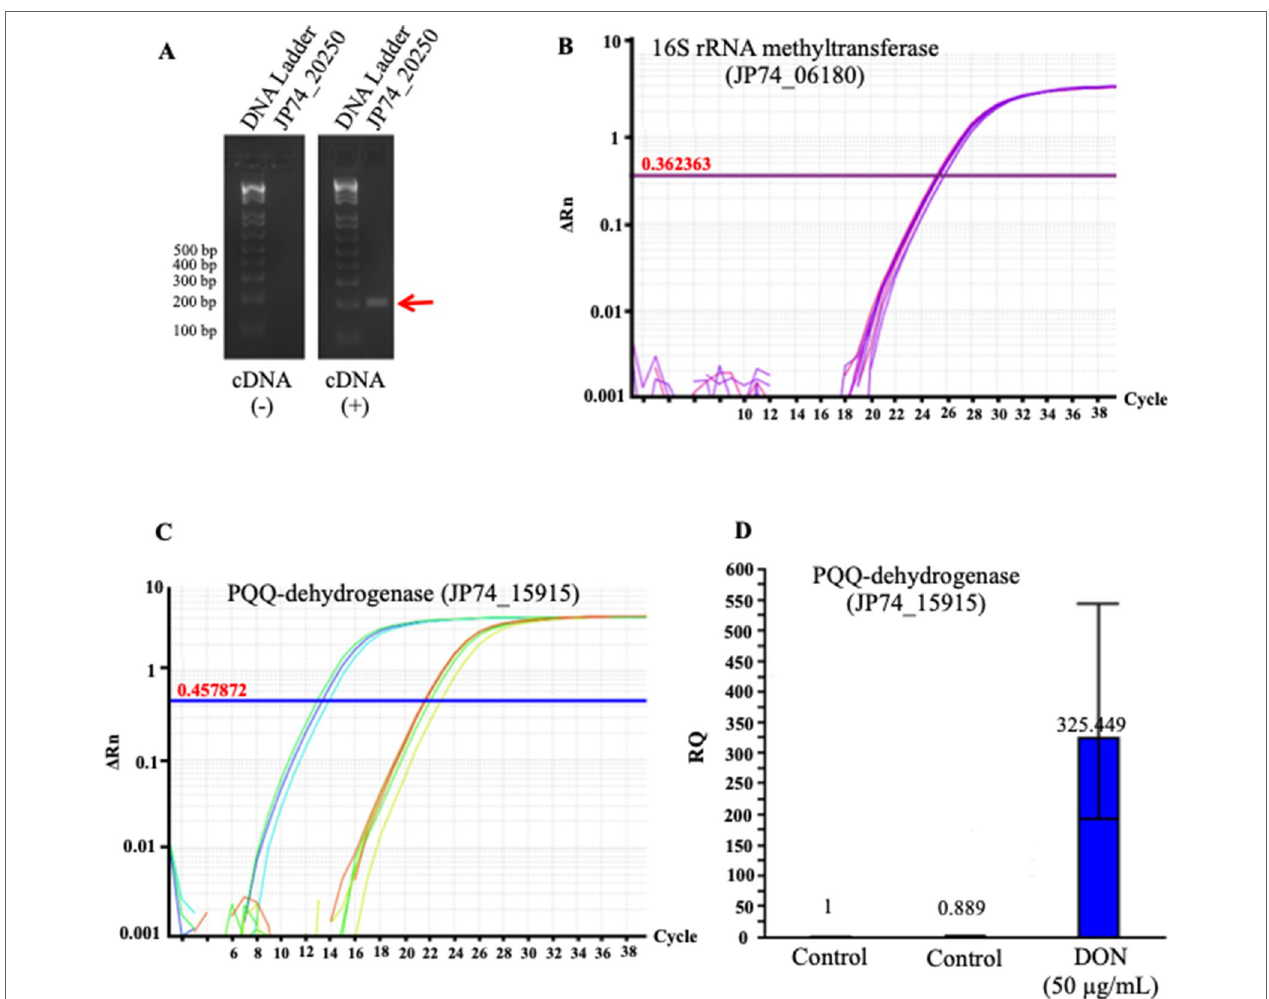
FIGURE 5 | The tendencies observed in the RNA_Seq results were confirmed using a quantitative and semiquantitative polymerase chain reactions (qPCR): (A) the semiquantitative detection/amplification of the JP74_20250 gene to check the quality of the prepared complementary DNA strands, (B) the 16S rRNA methyltransferase (JP74_06180) gene was used as the housekeeping gene for the normalization and calculation of fold increases of transcripts amplified using the qPCR approach, (C) an example of the qPCR amplification/detection of a PQQ-dependent dehydrogenase (JP74_15915) and its relative expression in response to DON (D) in comparison to unchallenged bacterial cells